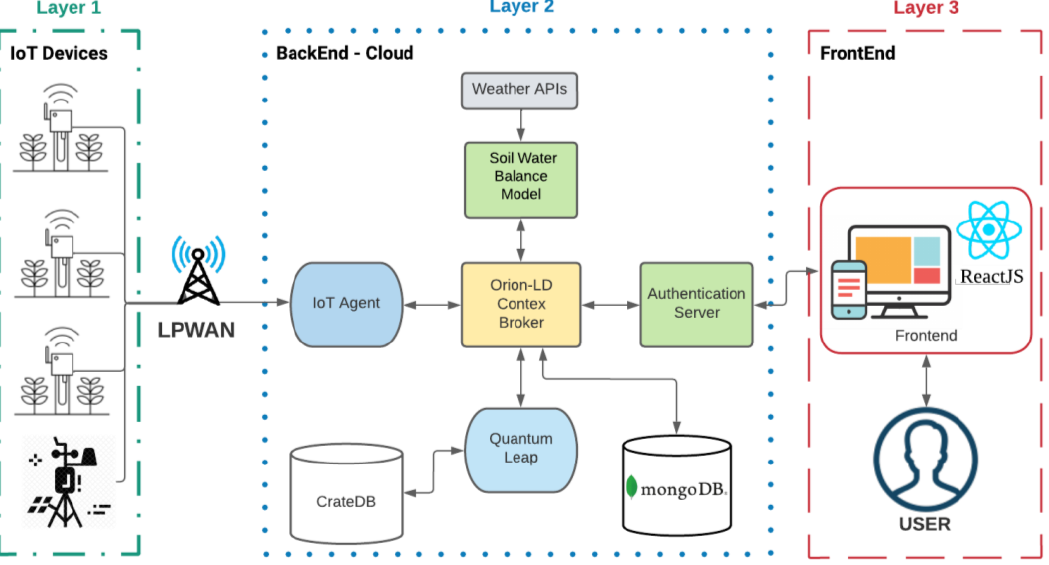
Figure 2. IoT Platform Architecture.